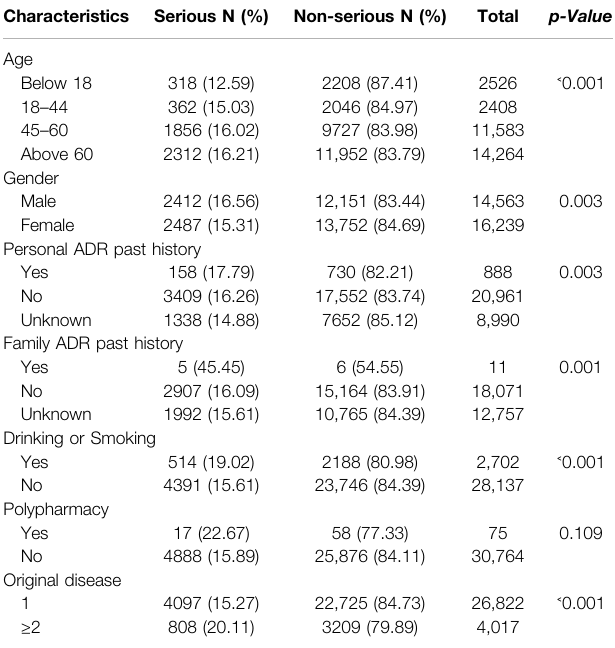
TABLE1| Numberandproportionofseriousandnon-seriousreportsbypersonal characteristics. Characteristics Serious N (%) Non-serious N (%)